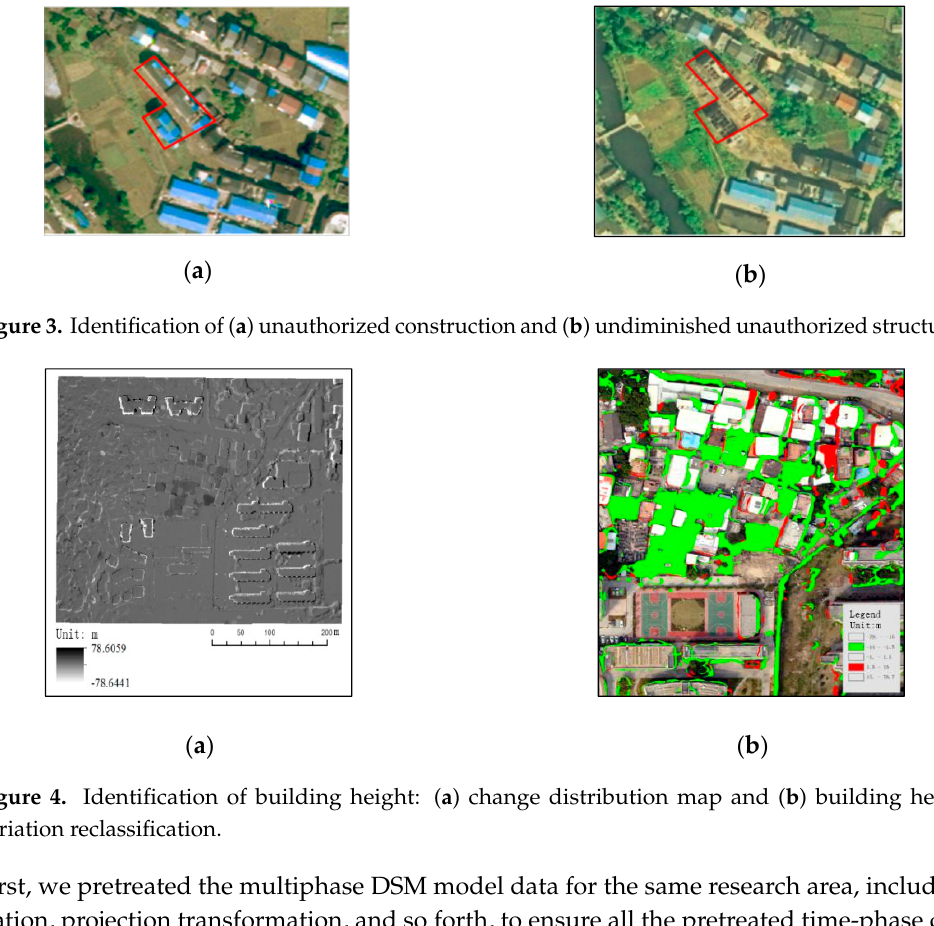
Figure 4. Identification of building height: ( a ) change distribution map and ( b ) building height variation reclassification.